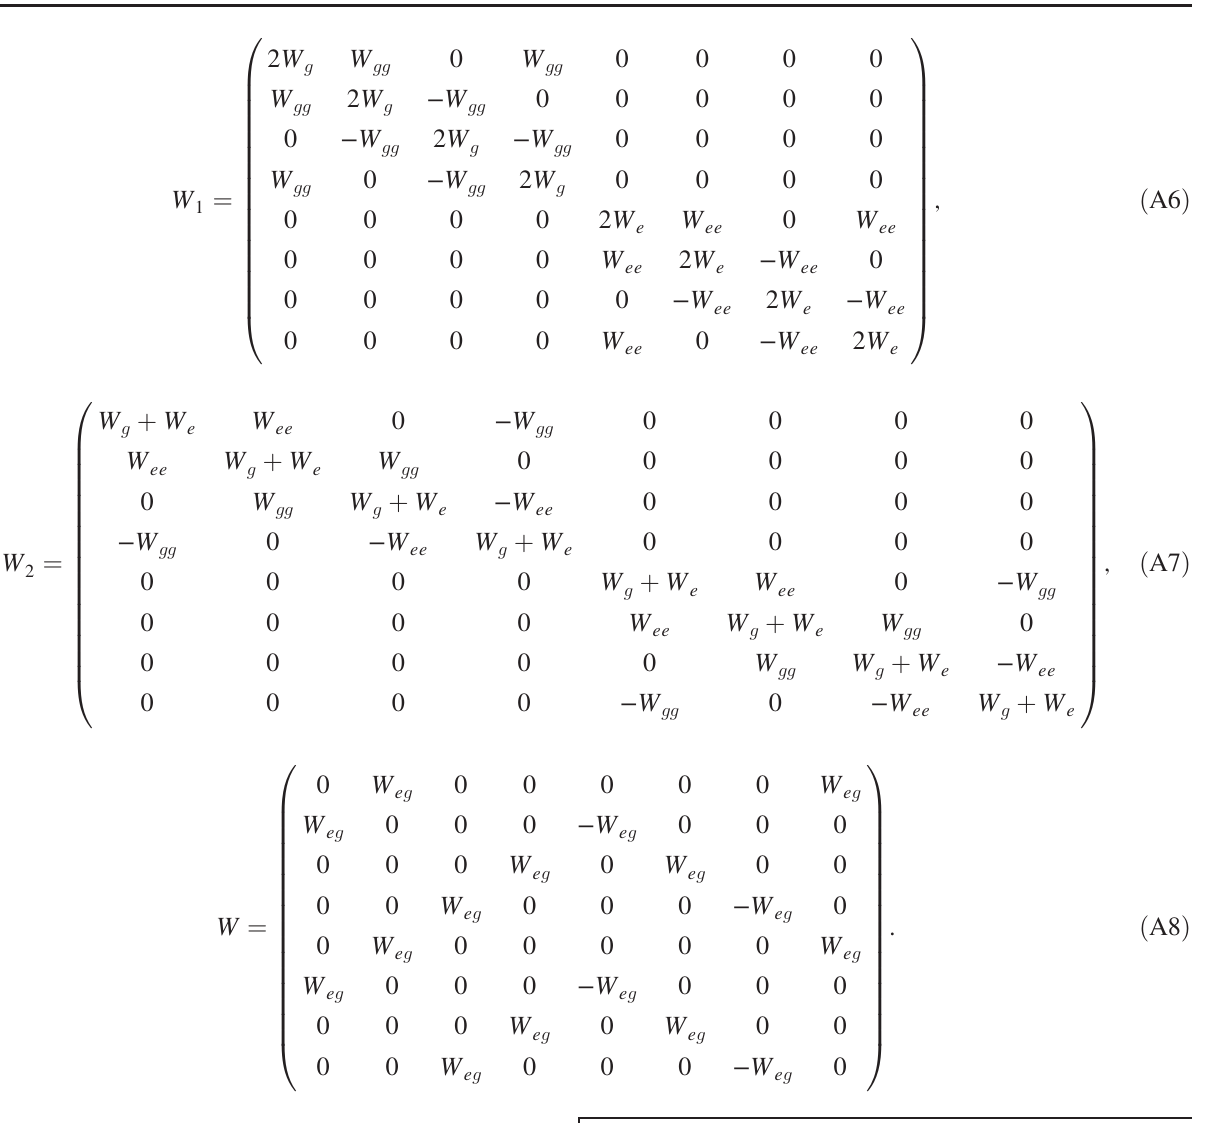
driving frequency ω = ð 2 π Þ ¼ 9420 Hz and strength α ¼ 0 . 5 . The four ground-band states are highlighted as colored solid lines. At zero interaction, an avoided crossing appears between the j s i and j D . When the i with gap 4 t g þ interaction becomes resonant to the driving frequency, we can observe another avoided crossing between the j s i and j D i state. A enlargement of this region is provided in þ Fig. 6(b), corresponding to the small black-boxed region in Fig. 6(a) at 9.5 kHz. This avoided crossing resembles the physics of the effective Floquet Hamiltonian in the lowest band [36]. However, the resonant coupling to the higher band creates an additional coupling between the ground- band state j D − i to a state j ϑ i involving both ground- and higher-orbital contributions. This unwanted process can be suppressed using the control drive. In Fig. 6(c), the addi- tional drive with strength γ ¼ 0 . 1 closes the gap without changing the gap opening between the lowest band